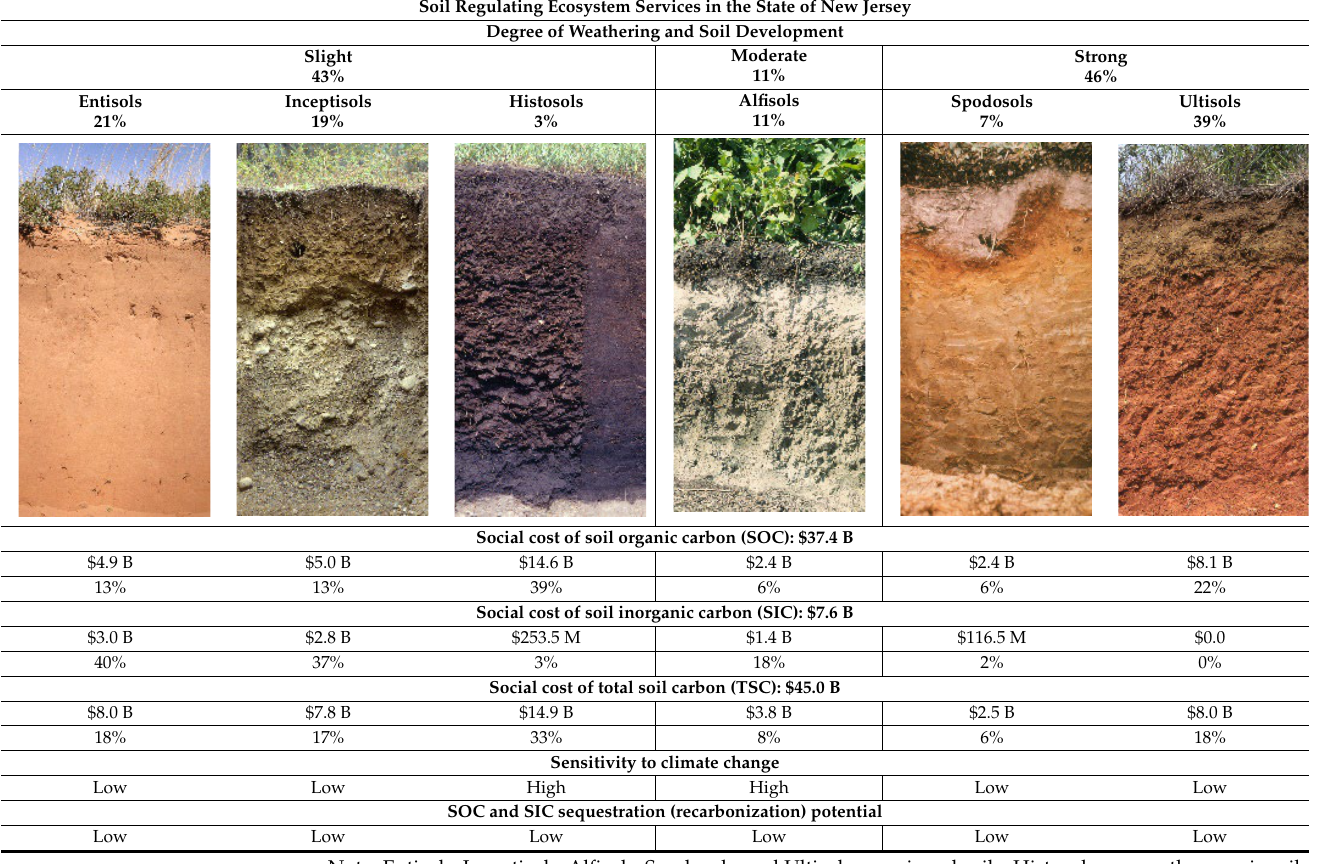
Table 9. Distribution of soil carbon regulating ecosystem services in the state of New Jersey (USA) by soil order (photos courtesy of USDA/NRCS [27]).